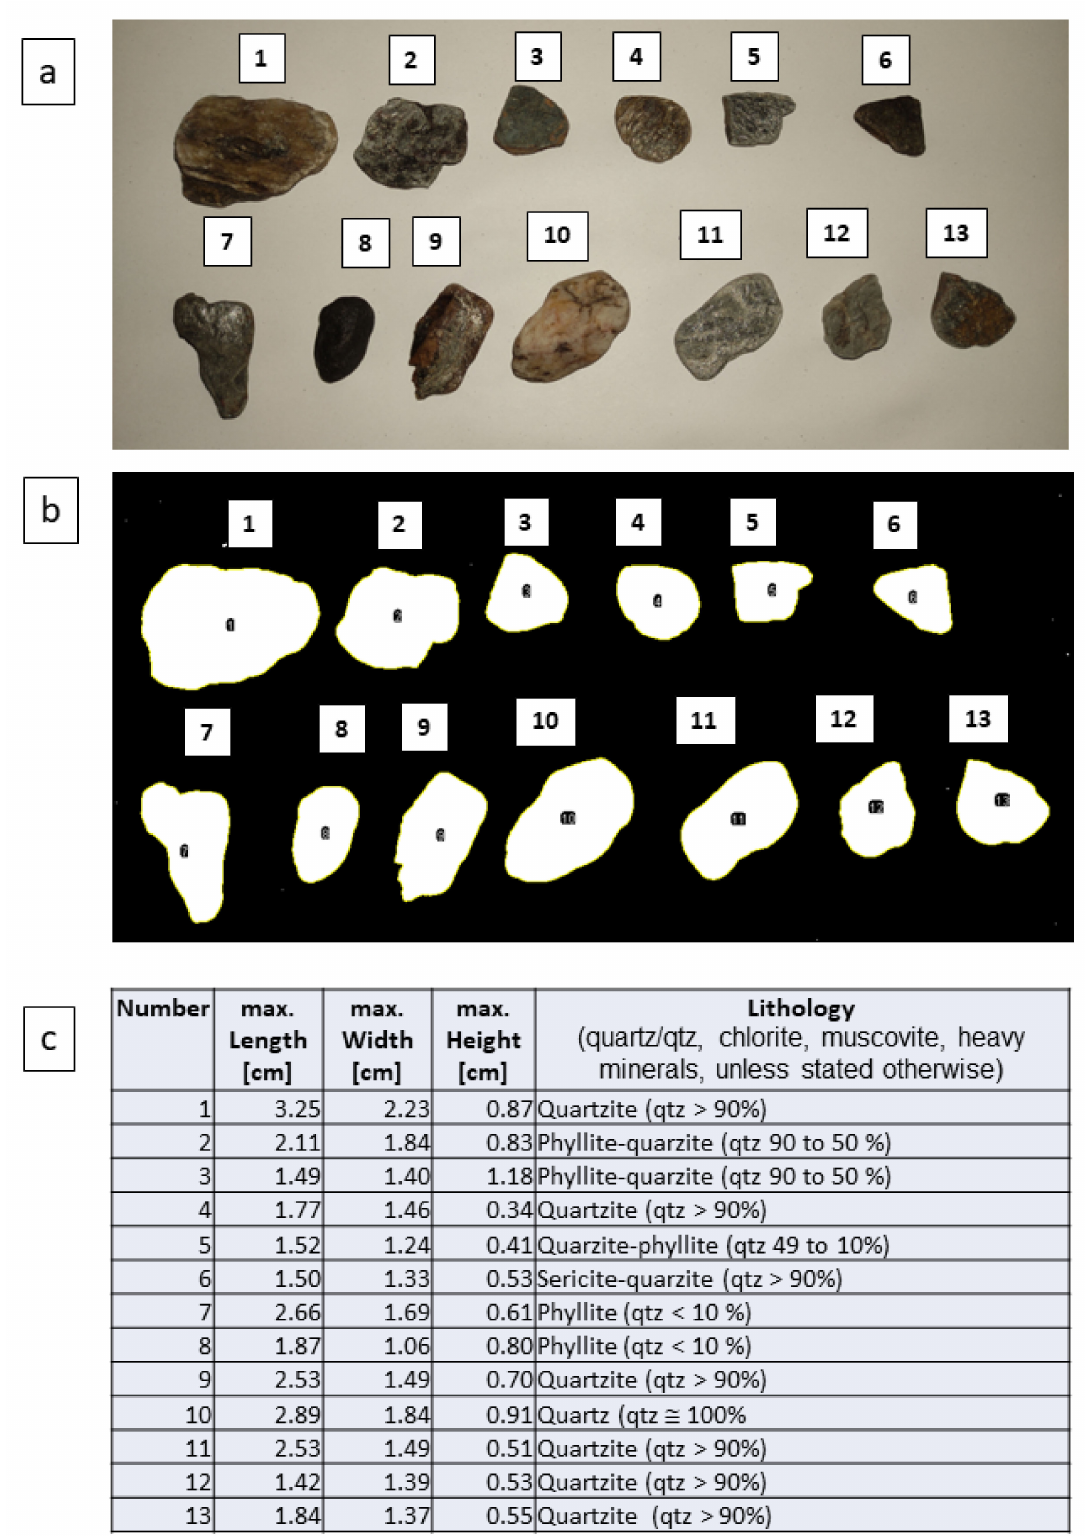
Figure 11. A comparison of 2-D and 3-D morphological grain analysis of gravel clasts selected from site 10. ( a ) Original gravel clasts with reference numbers. ( b ) Platform for the digital morphological scanning. ( c ) Composite of morphological 3-D data and a lithological